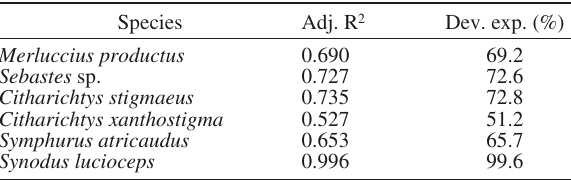
Fig. 2. – Seasonal climatology of absolute dynamic height of sea surface (ADT) during the period 1993-2013. A, winter; B, spring; C, summer; and D, autumn. Colours indicate the elevation of the ocean surface (cm) and line contours mark the trajectory of surface currents associated with elevation. Table 2. – Performance of the best-fitted GAMs for six demersal species. Adj. R 2 , adjusted R 2 ; Dev. exp., deviance